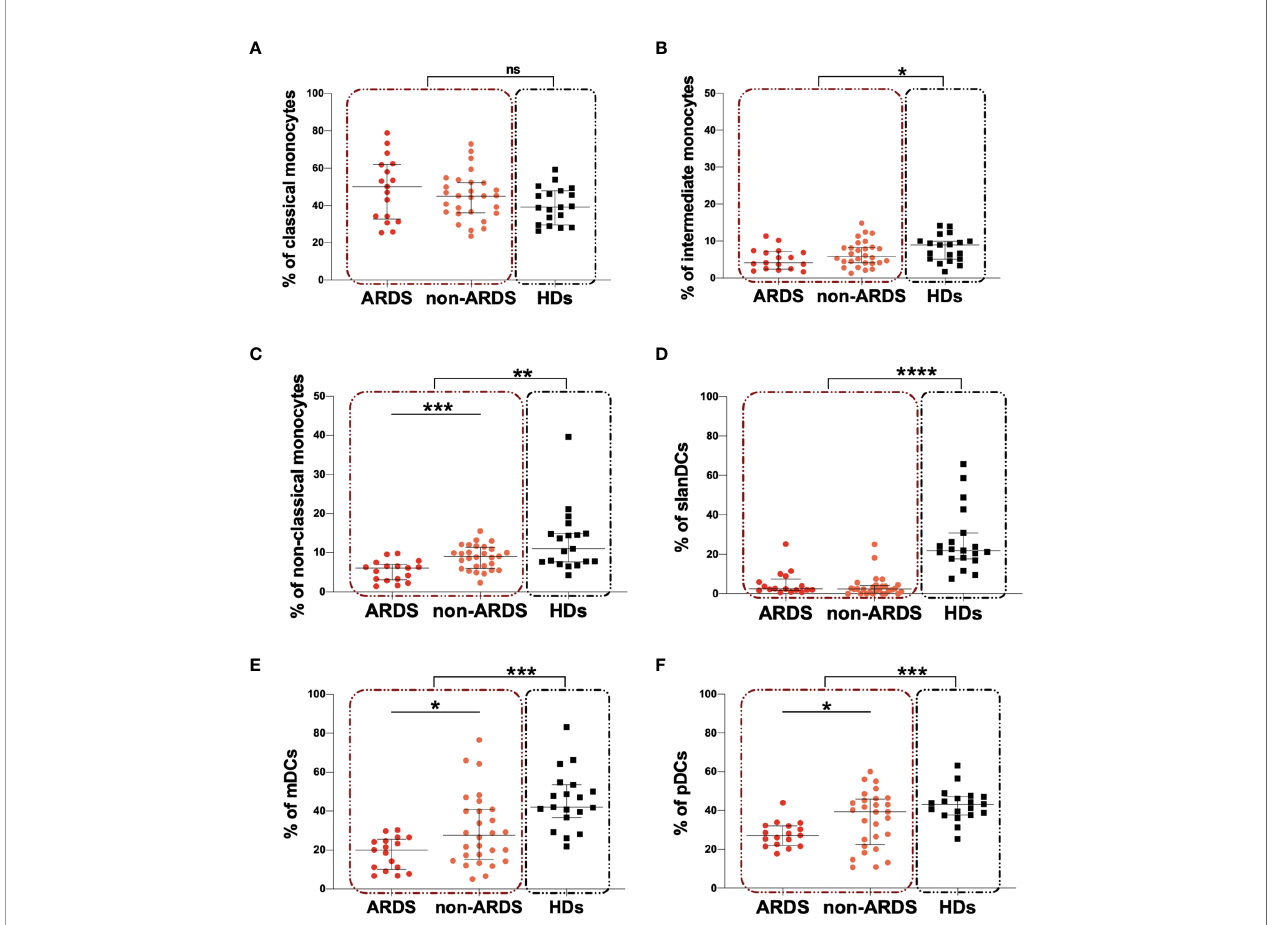
FIGURE 3 | Peripheral blood monocyte and DC subsets in COVID-19 subjects compared to HDs and according to the severity of the disease. (A) The percentage of classical monocyte was evaluated in 45 COVID-19 subjects (red dashed line box) and 19 HDs (black dashed line box). The differences were evaluated using the nonparametric Mann-Whitney test. Moreover, the percentages of classical monocyte were evaluated in 17 patients with ARDS (ARDS group) and in 28 patients without ARDS (non-ARDS group) using the nonparametric Mann-Whitney test. Data are shown as median (lines) and interquartile ranges (whiskers). (B) The percentage of intermediate monocyte was evaluated in 45 COVID-19 subjects (red dashed line box) and 19 HDs (black dashed line box). The differences were evaluated using the nonparametric Mann- Whitney test. Moreover, the percentages of intermediate monocyte were evaluated in 17 patients with ARDS (ARDS group) and in 28 patients without ARDS (non-ARDS group) using the nonparametric Mann-Whitney test. Data are shown as median (lines) and interquartile ranges (whiskers). (C) The percentage of non-classical monocyte was evaluated in 45 COVID-19 subjects (red dashed line box) and 19 HDs (black dashed line box). The differences were evaluated using the nonparametric Mann-Whitney test. Moreover, the percentages of non-classical monocyte were evaluated in 17 patients with ARDS (ARDS group) and in 28 patients without ARDS (non-ARDS group) using the nonparametric Mann-Whitney test. Data are shown as median (lines) and interquartile ranges (whiskers). (D) The percentage of slanDCs was evaluated in 45 COVID-19 subjects (red dashed line box) and 19 HDs (black dashed line box). The differences were evaluated using the nonparametric Mann-Whitney test. Moreover, the percentages of slanDCs were evaluated in 17 patients with ARDS (ARDS group) and in 28 patients without ARDS (non-ARDS group) using the nonparametric Mann-Whitney test. Data are shown as median (lines) and interquartile ranges (whiskers). (E) The percentage of mDCs was evaluated in 45 COVID-19 subjects (red dashed line box) and 19 HDs (black dashed line box). The differences were evaluated using the nonparametric Mann-Whitney test. Moreover, the percentages of mDCs were evaluated in 17 patients with ARDS (ARDS group) and in 28 patients without ARDS (non-ARDS group) using the nonparametric Mann-Whitney test. Data are shown as median (lines) and interquartile ranges (whiskers). (F) The percentage of pDCs was evaluated in 45 COVID-19 subjects (red dashed line box) and 19 HDs (black dashed line box). The differences were evaluated using the nonparametric Mann-Whitney test. Moreover, the percentages of pDCs were evaluated in 17 patients with ARDS (ARDS group) and in 28 patients without ARDS (non-ARDS group) using the nonparametric Mann-Whitney test. Data are shown as median (lines) and interquartile ranges (whiskers). mDCs, myeloid dendritic cells; pDCs, plasmacytoid dendritic cells; ns, not signi fi cant. *0.05<p<0.01; **0.01<p<0.001; ***p<0.001;